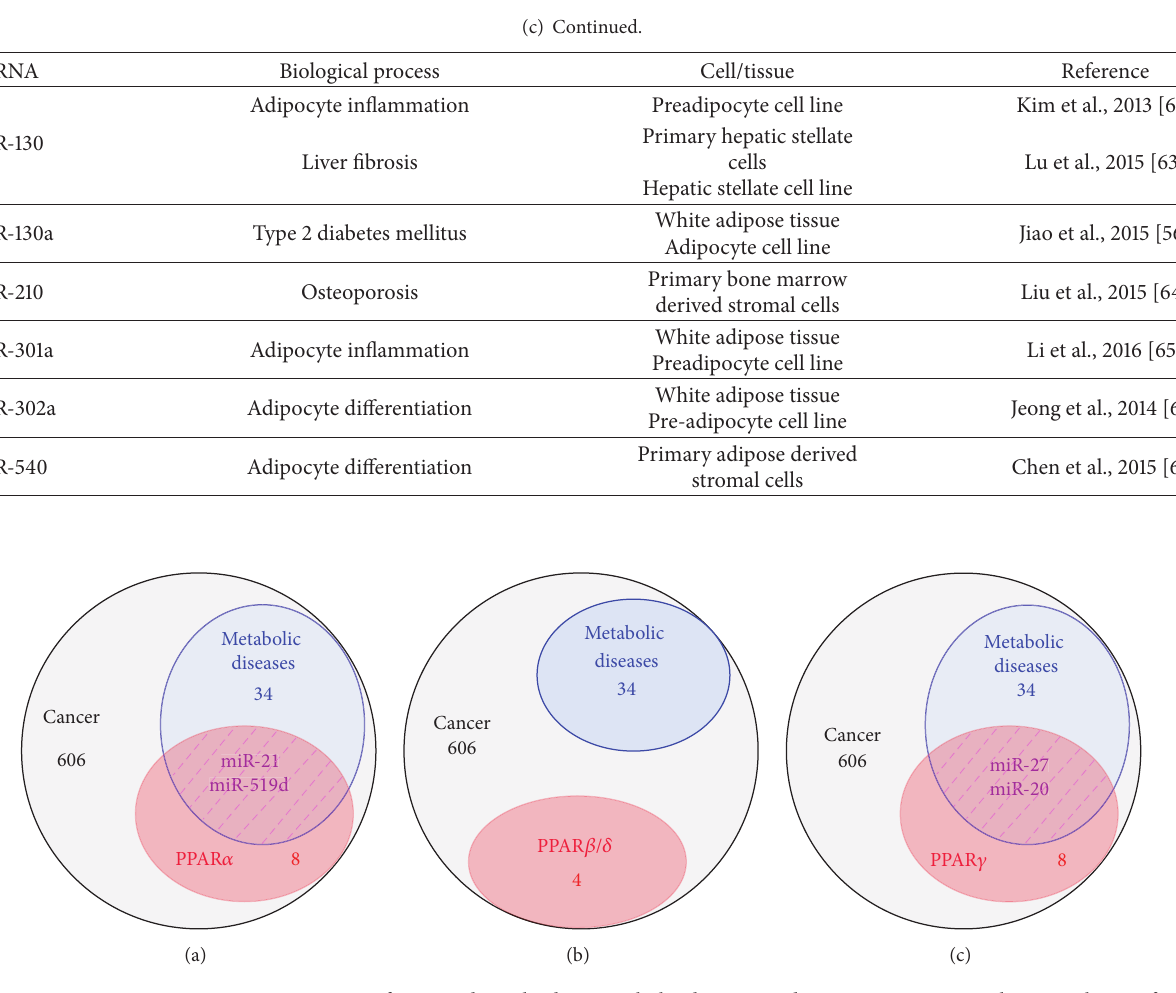
Figure 1: Human miRNAs targeting PPAR isoforms and involved in metabolic diseases and cancer. MetaCore pathway analysis software from Thomson Reuters was used to identify experimentally the number of validated human miRNAs involved in cancer (grey circle). Among those, the numbers of miRNAs involved in metabolic diseases, also identified by MetaCore pathway analysis, are indicated in blue circles. In red circles are the number of miRNAs identified using miRWalk 2.0 atlas and targeting PPAR 𝛼 (Panel (a)), PPAR 𝛽 / 𝛿 (Panel (b)), and PPAR 𝛾 (Panel (c)). The identities of miRNAs targeting specific PPAR isoforms and involved in both cancer and metabolic diseases are indicated in violet. miRWalk 2.0 atlas is a software integrating 12 different prediction algorithms (miRWalk 2.0, MicroT4, miRanda, miRBridge,